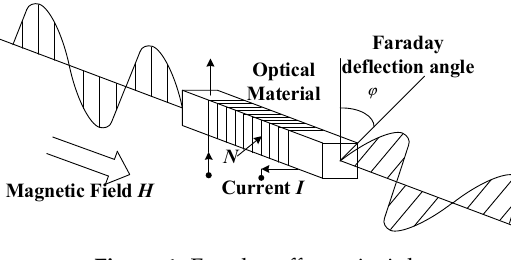
Figure 1. Faraday effect principle. Figure 1. Faraday e ff ect